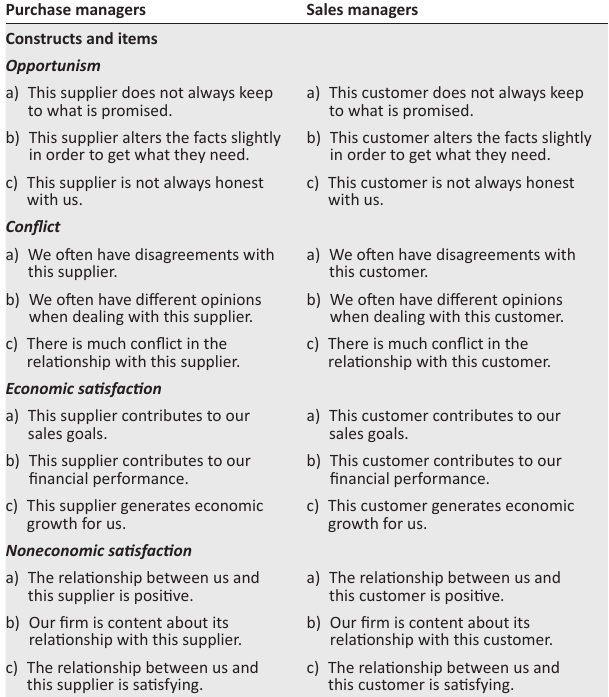
TABLE 3: Antecedents and postcedents construct items in purchase and sales business